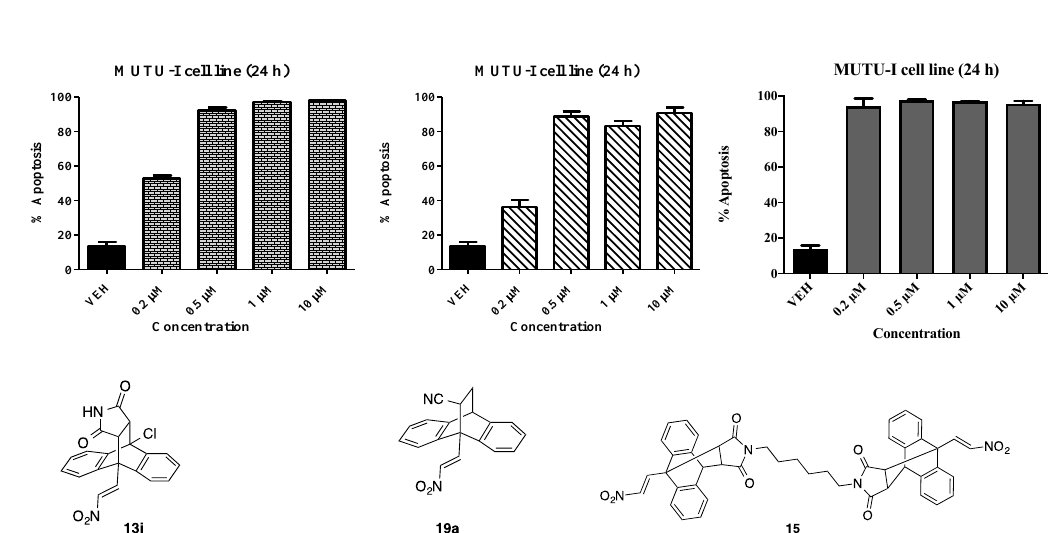
Figure 4. Ethanoanthracene nitrostyrene compounds 16a – d , 13j , 19a , 15 induce apoptosis in Burkitt’s lymphoma MUTU-1 cell line. Induction of apoptosis in Burkitt’s lymphoma MUTU-1 cell line following treatment for 24 h with selected ethanoanthracene nitrostyrene compounds (0.2 – 10 μ M) or a comparative control (taxol) in MUTU-1 cell line is determined using Annexin V and propidium iodide staining/FACS. ( A ) Taxol, 12 , 16a ; ( B ) 16b , 16c , 16d ; ( C ) 13j , 19a , 15 . Ethanol was used as the vehicle. Values represent the mean of three independent experiments.